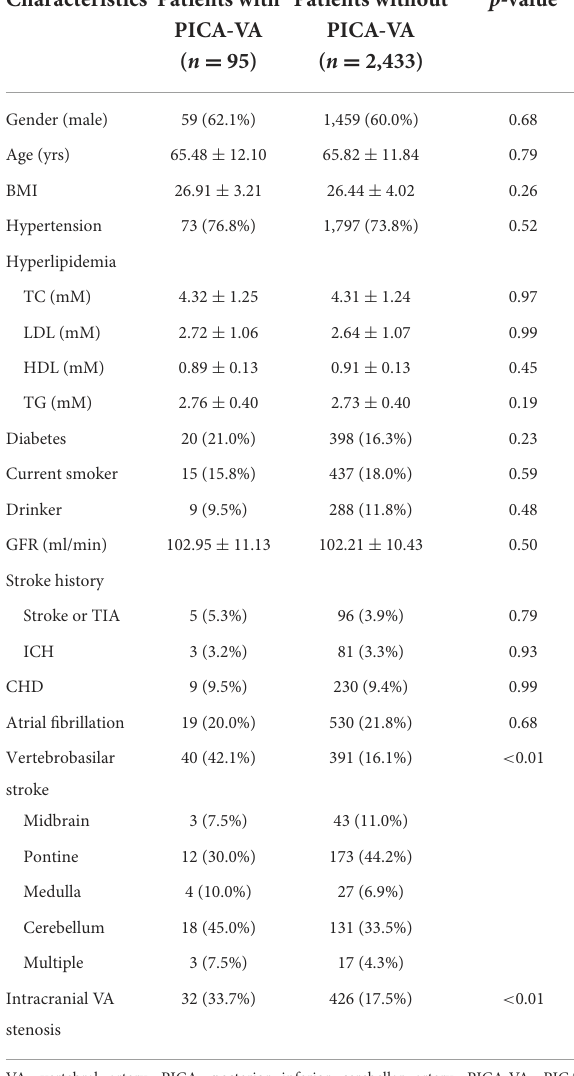
TABLE 2 Characteristics of stroke patients with or without posterior circulation stroke.